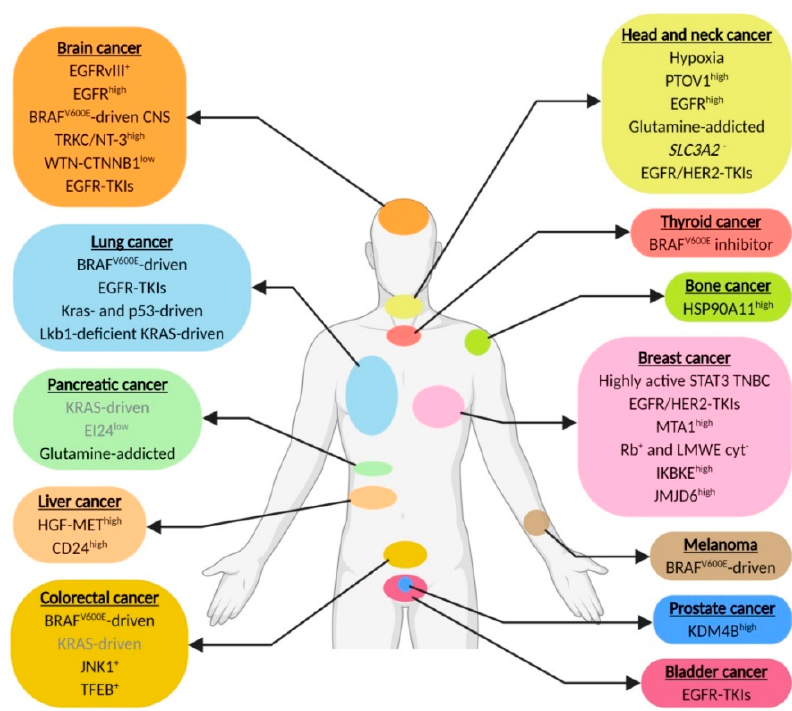
Figure 1. Genetic changes and chemotherapy-resistance mechanisms that contribute to elevate autophagy dependence. Biomarkers in grey require further investigation (created using Https://Biorender.com).